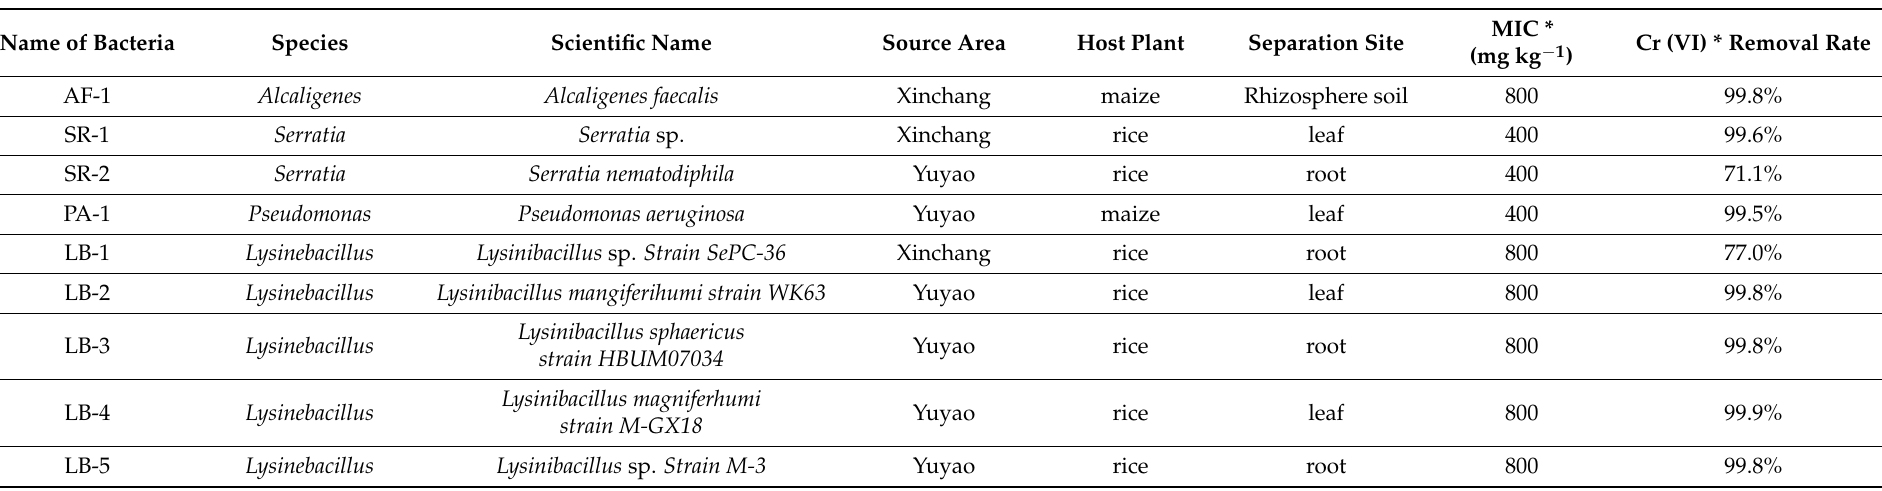
Table 1. Characteristics of nine different Cr-tolerant bacteria isolated from the rhizosphere soil and plant of crops in Cr-contaminated